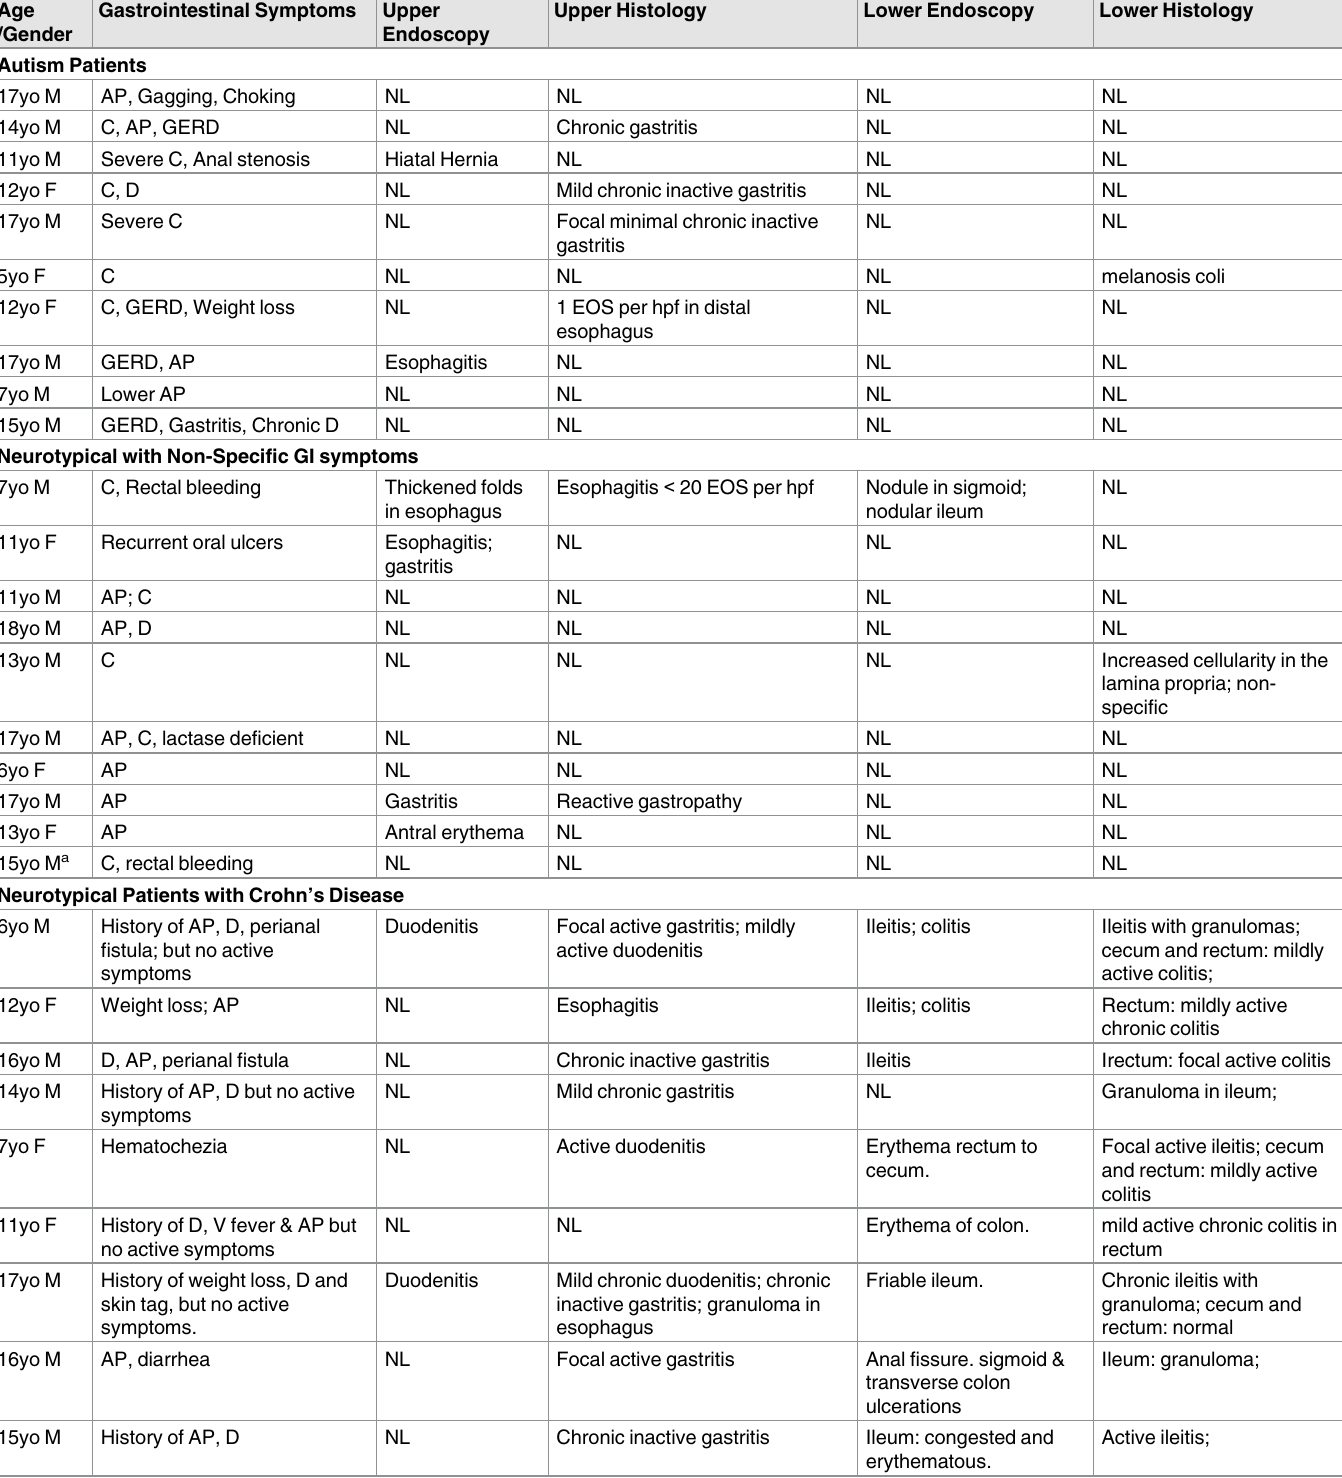
Table 1. Patient symptoms and gastrointestinal